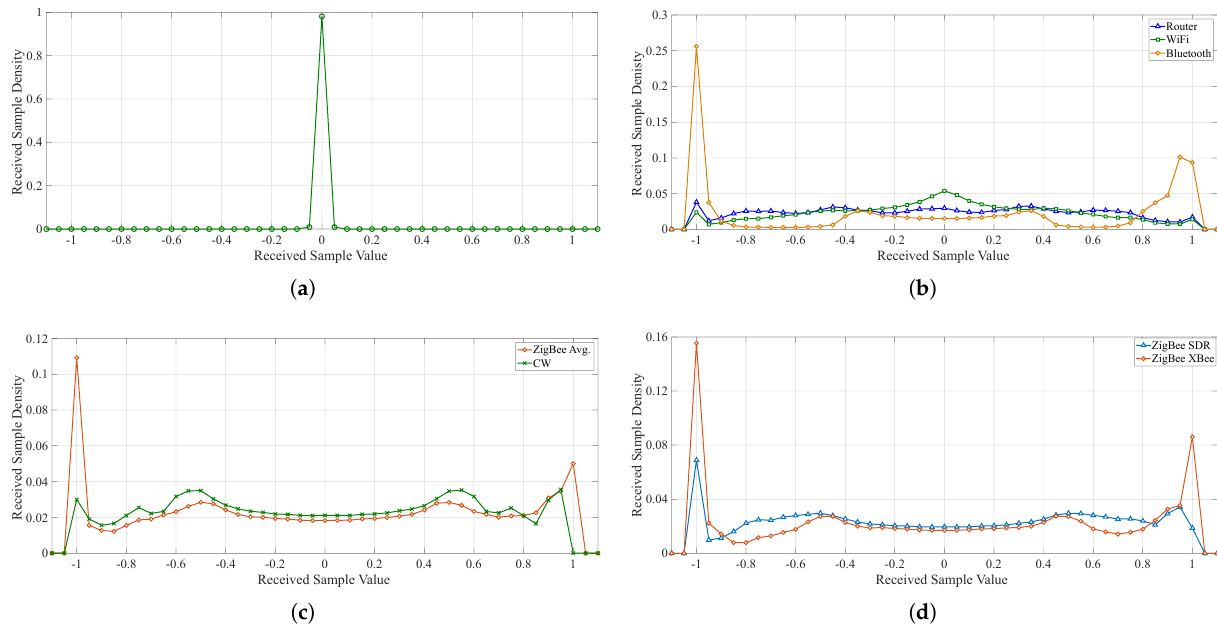
Figure 7. Calculated PDFs of the wirelessly received I/Q samples for a subset of signals operating in the 2.4 GHz ISM band. Signals are split into groups for ease of visualization. ( a ) The calculated PDF for the inactive noise channel in the operating environment, illustrating the relatively quite channel. ( b ) The computed PDFs for received WiFi, router without internet connectivity and Bluetooth advertising signals. ( c ) The PDFs for the received CW and ZigBee signals for various power levels. ( d ) The calculated PDFs of the received legitimate ZigBee-XBee and